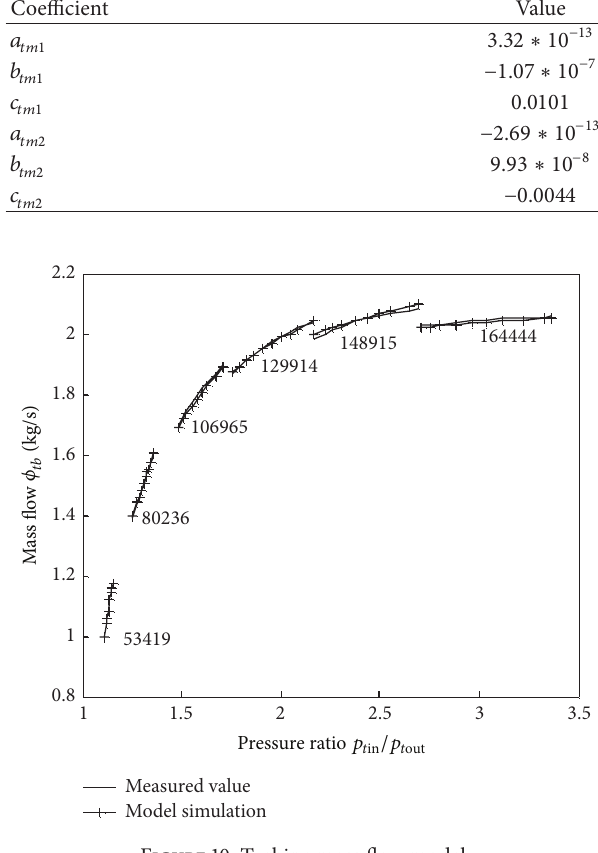
Figure 10: Turbine mass flow